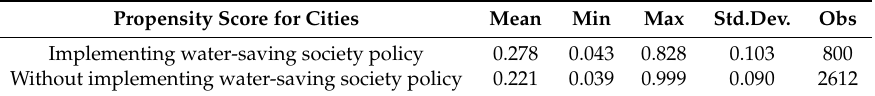
Table 2. Propensity score distribution for treated and control cities.